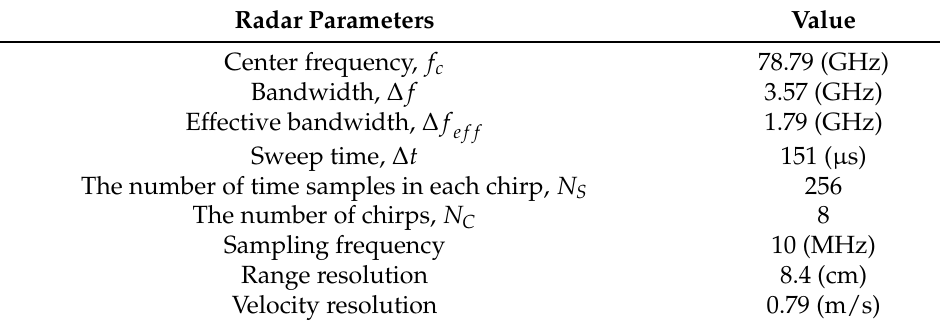
Figure 6. Radar sensor module used in our experiments. Table 1. Radar parameters used in the FMCW radar